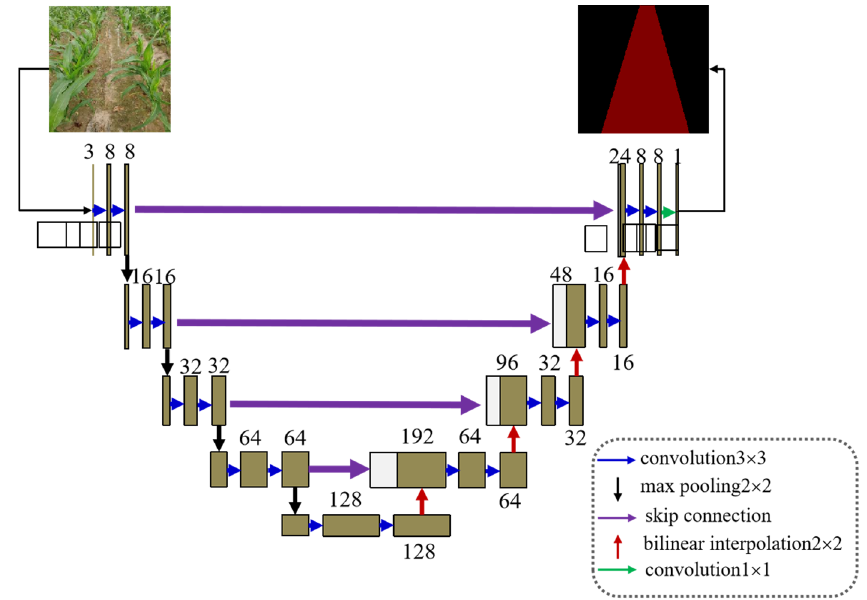
Figure 4. Faster-U-net network model structure.